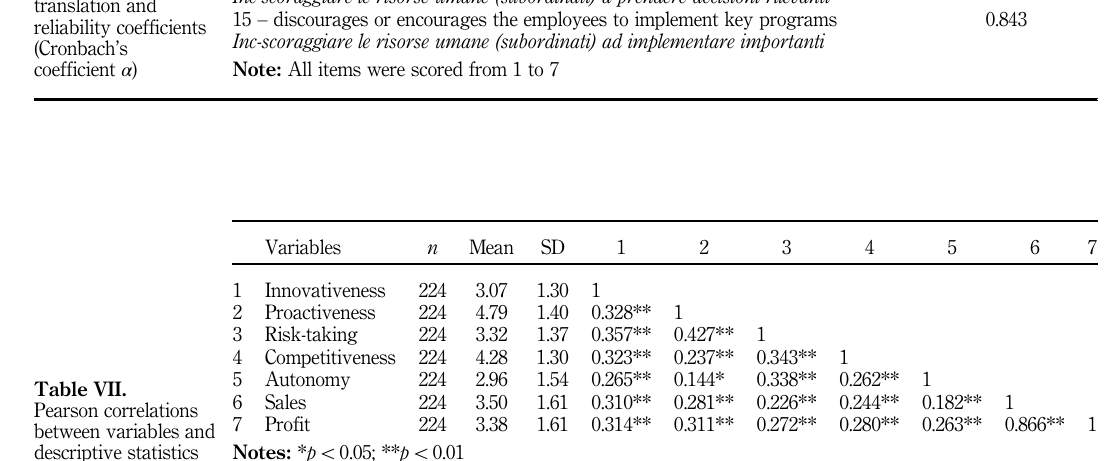
Table VII. Pearson correlations between variables and descriptive